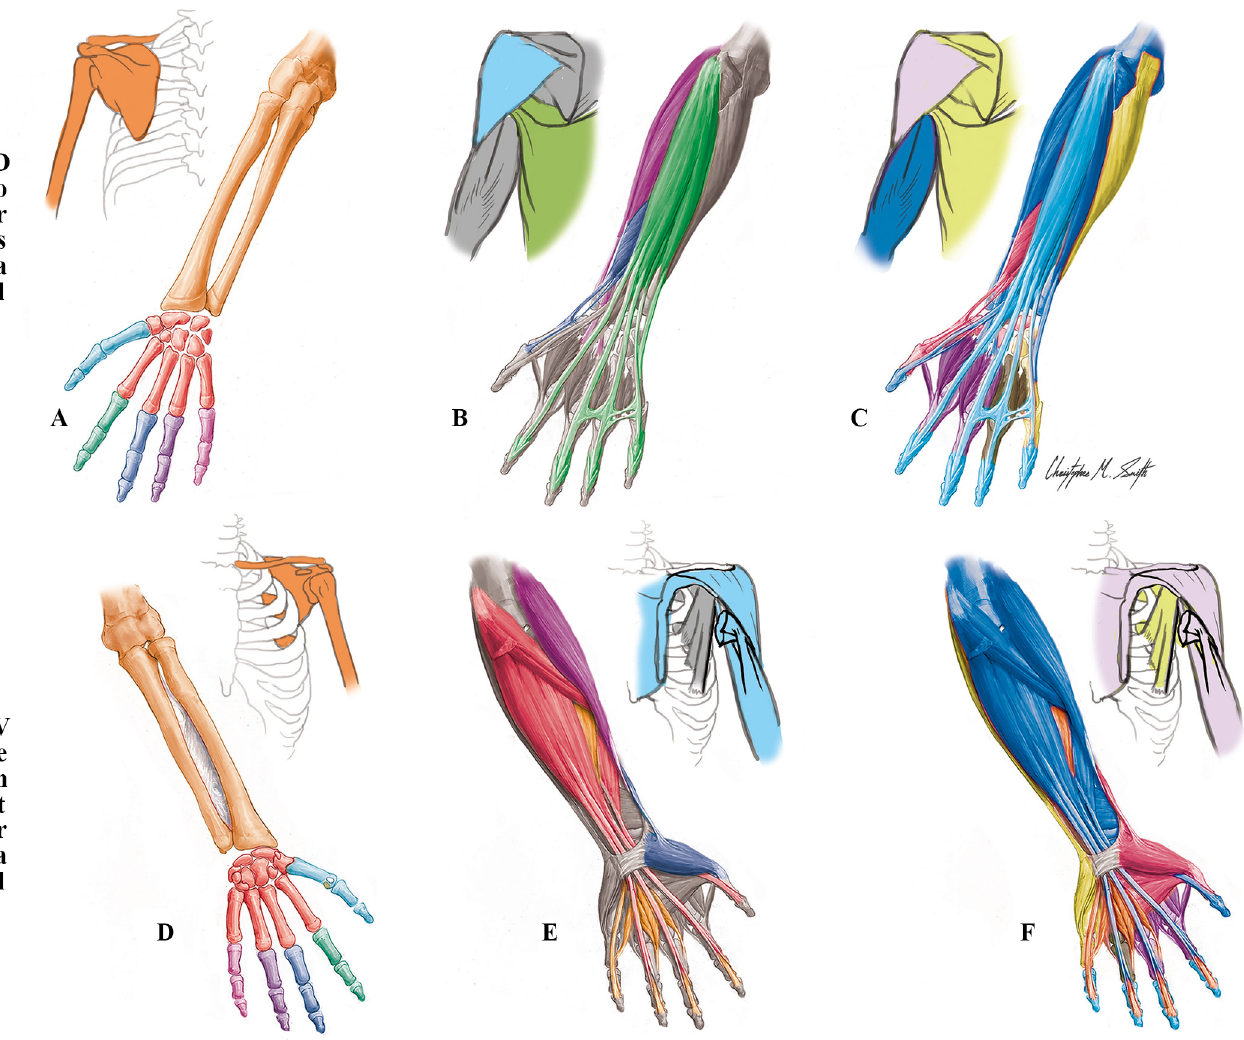
Fig 5. Modules of the T18 cyclopic fetus left UL identified using AnNA. A to C dorsal (extensor) view; D to F ventral (flexor) view. A, D) Skeletal network modules: as in normal adult/newborn (see Fig 1). B, E) Muscle network modules: in dark green , the ulnar extensor module; in purple , the radial extensor module; in dark blue , the thumb module; in red , the flexor module; in orange , the profundus/lumbrical module; in light blue , the biceps/deltopectoral module; and in light green , the latissimus dorsi/teres major module. C, F) Musculoskeletal network modules: in blue , the forearm-thumb movement module; in purple , the digits 2 – 3 movement module; in turquoise , the extensor module; in red , the thumb movement module; in orange , the profundus/lumbrical module; in brown , the digit 4 movement module; in light green , the scapular module; in pink , the clavicle movement/biceps module; and in yellow , the digit 5 movement